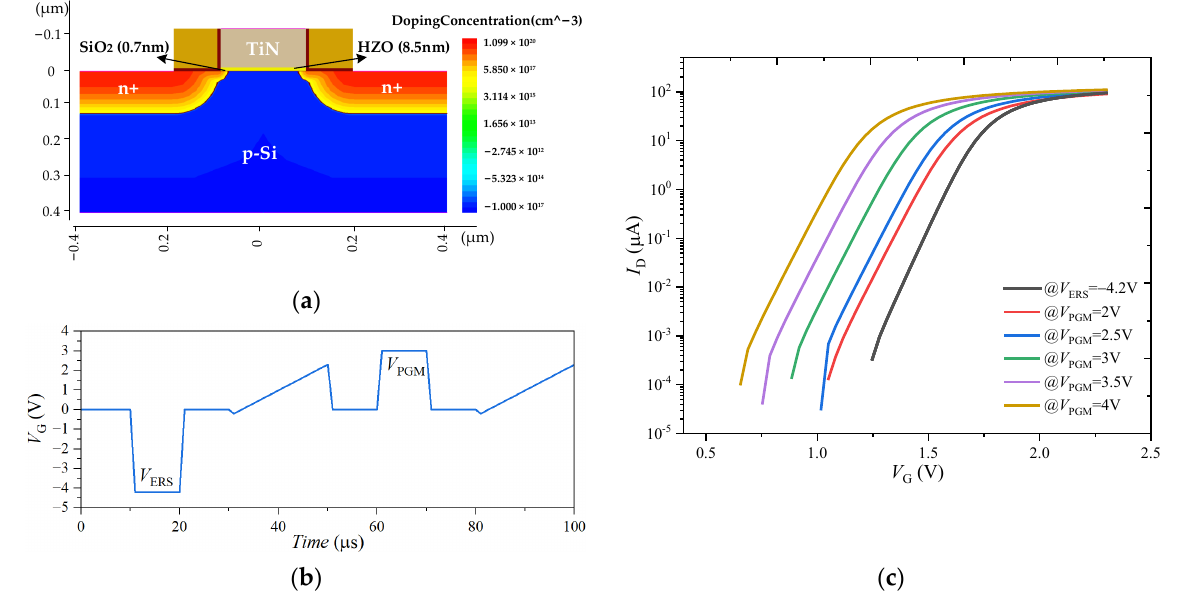
Figure 12. ( a ) Simulated structure of FeFET in Sentaurus TCAD. ( b ) Program/Erase pulse scheme along with the read cycle (sweep from −0.2 V to 2.5 V) for FeFET simulation. ( c ) Simulated I D - V G characteristics of FeFET for varying V PGM .